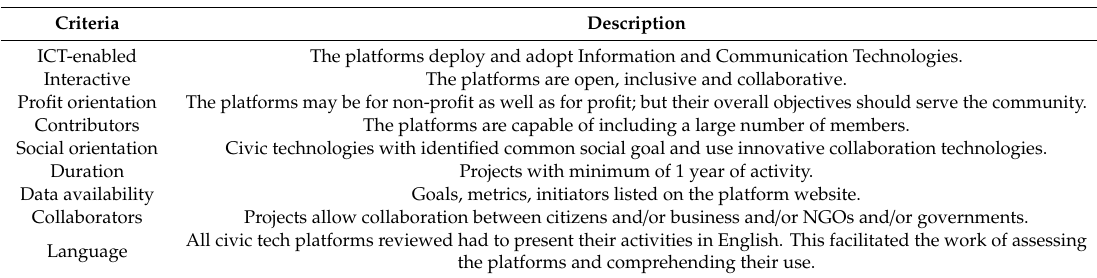
Table 1. The Research Sample Selection